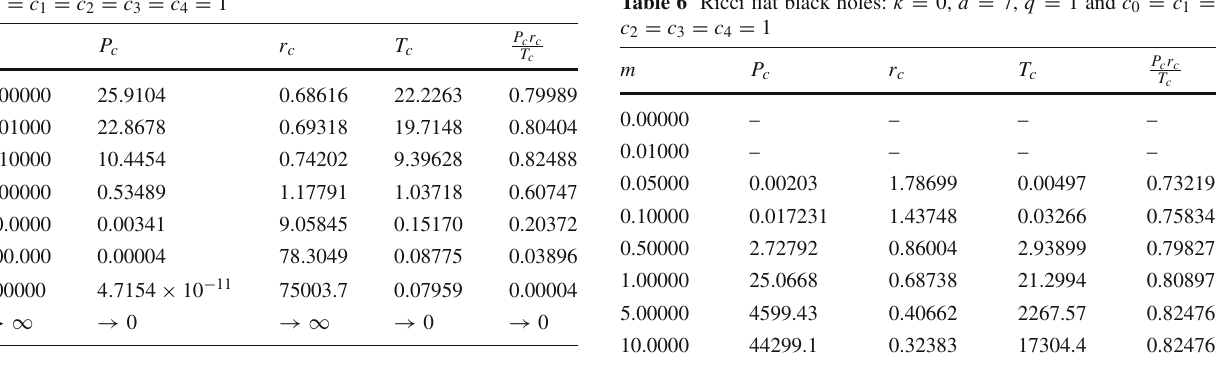
Table 3 Spherical black holes: k = 1, d = 7, q = 1, m = 1, and